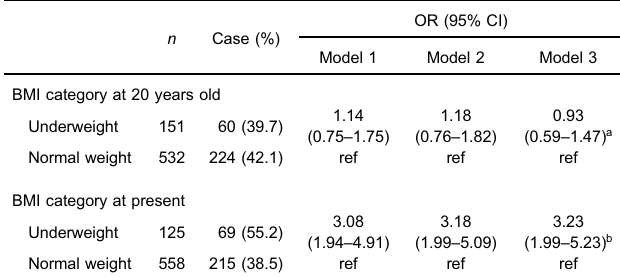
Table 5. Multivariate-adjusted odds ratios of the presence of underweight participants at 20 years old and/or osteopenia among women with BMI less than 25.0kg/m